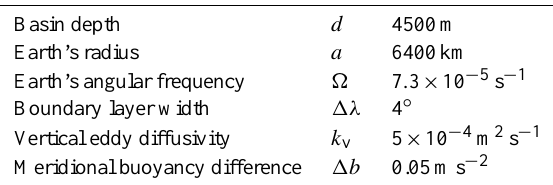
Table 2. External parameters as employed in the standard setup. Basin depth d 4500m